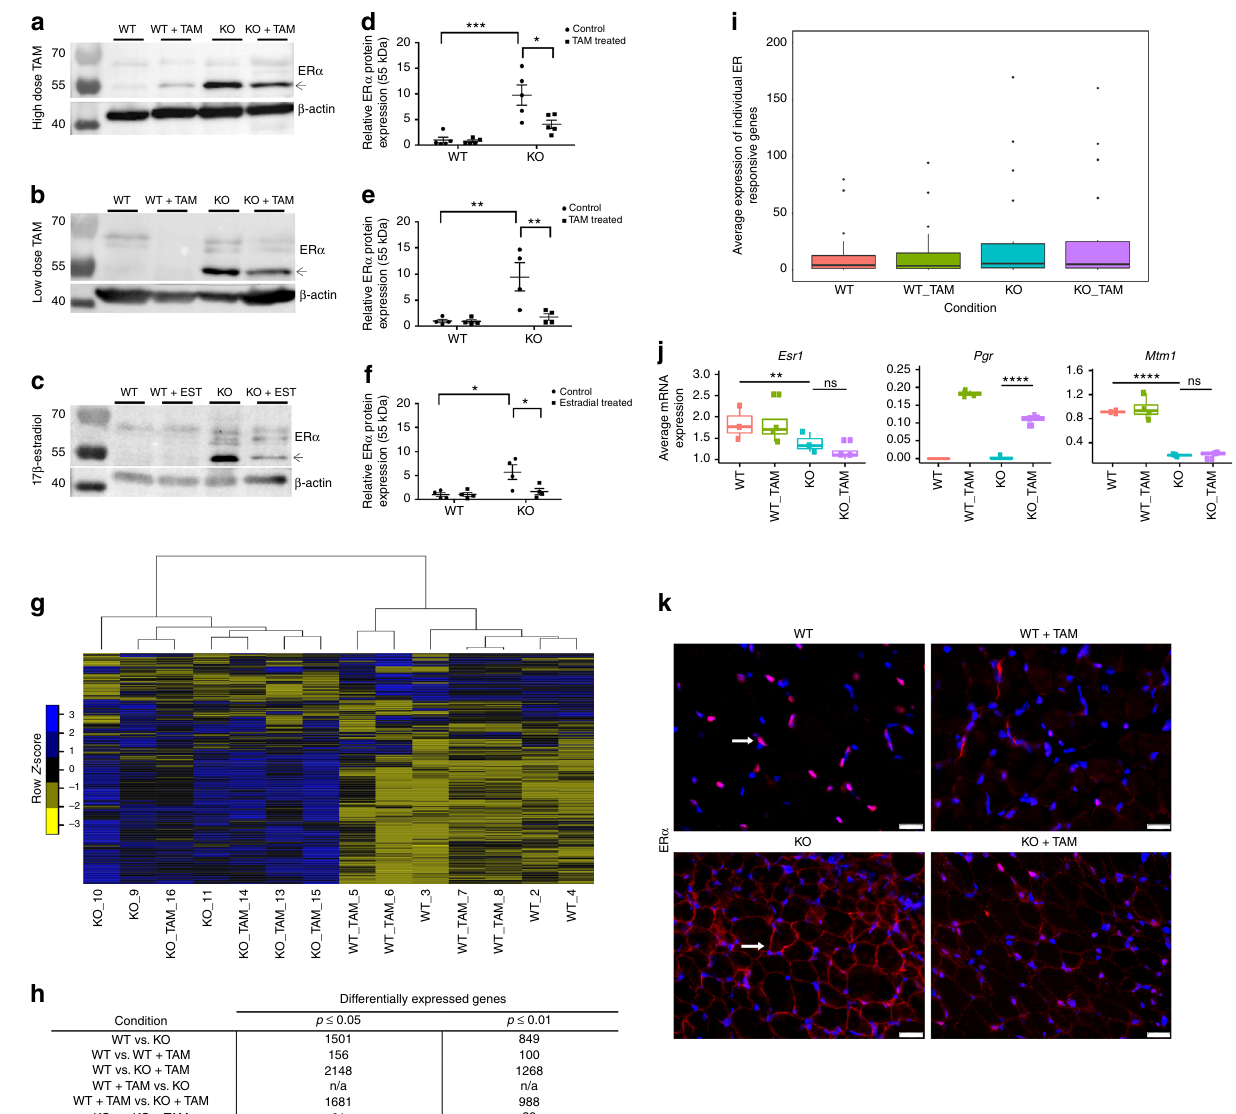
h vs. WT + TAM WT vs. KO + TAM WT + TAM vs. KO WT + TAM vs. KO + TAM KO vs. KO + TAM Fig. 6 Tamoxifen treatment does not alter the Mtm1 knockout transcriptome. a – c Representative western blots for ER α (with β -actin loading control) for WT, WT + TAM, Mtm1 KO, and tamoxifen (TAM) treated Mtm1 KO mice (molecular weight markers indicated in kDa). d – f Quanti fi cation of protein levels of the 55 kDa isoform of ER α as determined by densitometry with standardization to β -actin and represented as fold difference from the average of WT ( n = 5 mice per group for high-dose TAM, n = 4 mice per group for low-dose TAM and estradiol. Statistical analyses were conducted by two-way ANOVA, followed by Tukey ’ s multiple comparisons post-test * p < 0.05, ** p < 0.01, *** p < 0.001, **** p < 0.0001. Complete data points presented in Supplementary Table 4. g Heat map indicating overall mRNA expression pro fi les (derived from RNA-seq) of the four experimental groups, blue = high expression, yellow = low expression. Mtm1 KO and Mtm1 KO + TAM heat maps cluster together and are distinct from WT and WT + TAM. h Table indicating the total number of gene transcripts in each comparison with signi fi cantly differentially expression ( n = 3 mice per group for WT, n = 4 for WT + TAM, n = 3 for KO, and n = 4 for KO + TAM). Note that only 29 genes are differentially expressed ( p ≤ 0.01, DEseq and EdgeR R/Bioconductor pairwise comparisons) in Mtm1 KO vs. Mtm1 KO + TAM. i Box plot indicating the average expression of 21 estrogen receptor-responsive genes within each experimental group; no overall differences are observed with TAM treatment. j Individual expression box plots of Esr1 and Pgr1 , the only signi fi cantly changed estrogen response genes, and of Mtm1 . Box plots show the median, the 25th and 75th percentiles, and outliers. k Immuno fl uorescence with anti-ER α (red; indicated by a white arrow) on tibialis anterior muscle sections from WT, WT + TAM, Mtm1 KO, and Mtm1 KO + TAM (blue = DAPI) ( n = 3 mice per group for WT and WT + TAM, n = 4 mice per group for KO and KO + TAM). ER α is expressed primarily in the nucleus in WT muscle (arrow) but found at the sarcolemmal membrane in Mtm1 KOs (arrow). Overall ER α expression and its membrane localization are reduced with TAM treatment. Scale bars = 20 µ